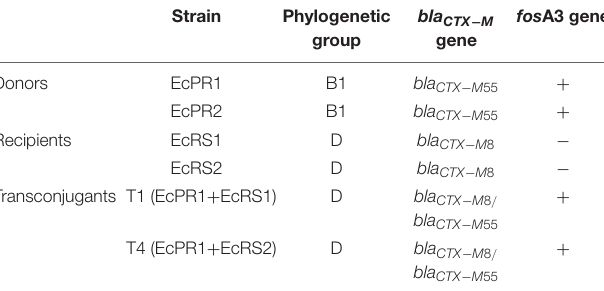
TABLE 3 | Conjugation experiment between ESBL-producing E. coli from poultry litter and non-ESBL-producing E. coli from the microbiota of